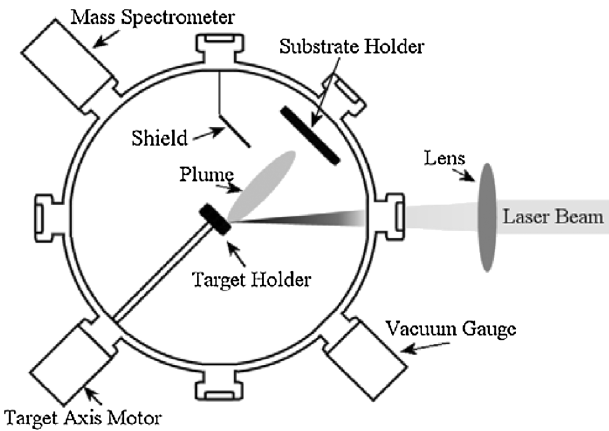
FIG. 1. Schematics of the pulsed laser deposition